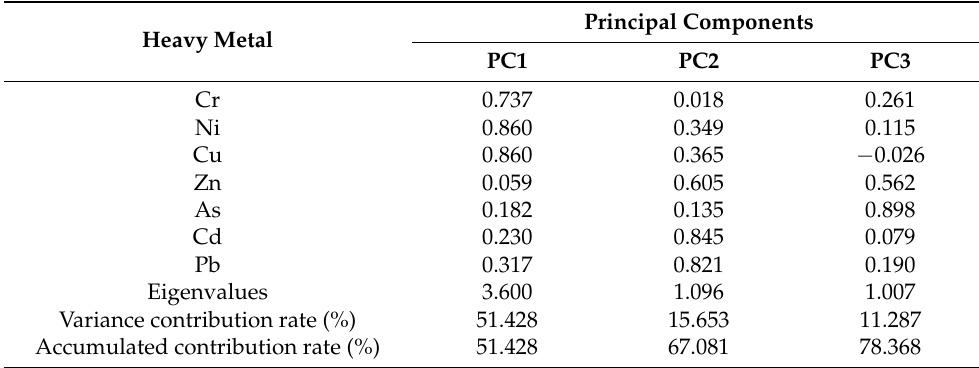
Figure 3. Distribution of heavy metal concentrations in water within the studied area. Table 5. Composition matrix after the